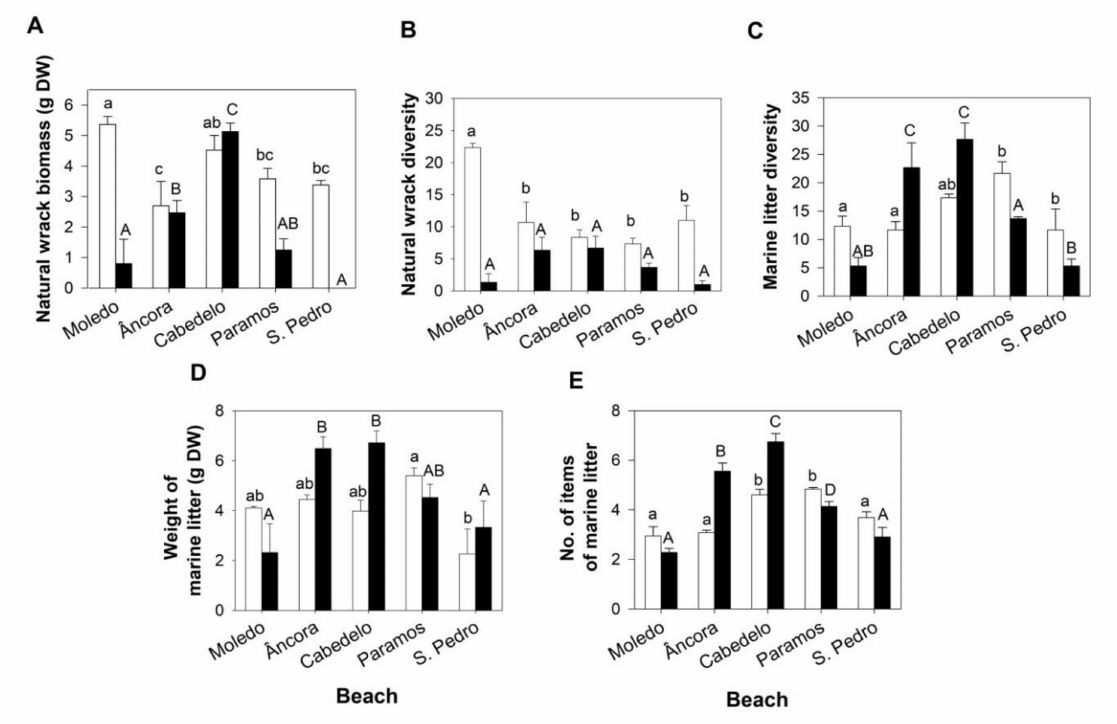
Figure 3. Averages per transect (mean + SE) of the total biomass of the natural wrack ( A ), natural wrack diversity ( B ), marine litter diversity ( C ), weight ( D ) and number of items ( E ) of marine litter on each beach in the North of Portugal in summer of 2019 (white) and in winter of 2020 (black). Natural wrack biomass were Ln(x + 1) transformed and weight and items of marine litter were transformed to Ln(x). Di ff erent letters indicate significant di ff erences ( p < 0.01) among beaches in summer (lowercase letters) and winter (capital letters). Table 2. PERMANOVA results of the e ff ects of the beach (Moledo, Â ncora, Cabedelo, Paramos and S ã o Pedro de Maceda) and dates (summer and winter) on the multivariate data of natural wrack assemblages (based on taxa biomass) and assemblages of marine litter based on weight and items of OSPAR categories. Significant di ff erences are highlighted in bold ( p < 0.01). Natural Wrack Marine Litter Assemblage Marine Litter Assemblage Assemblage Based on Weight Based on